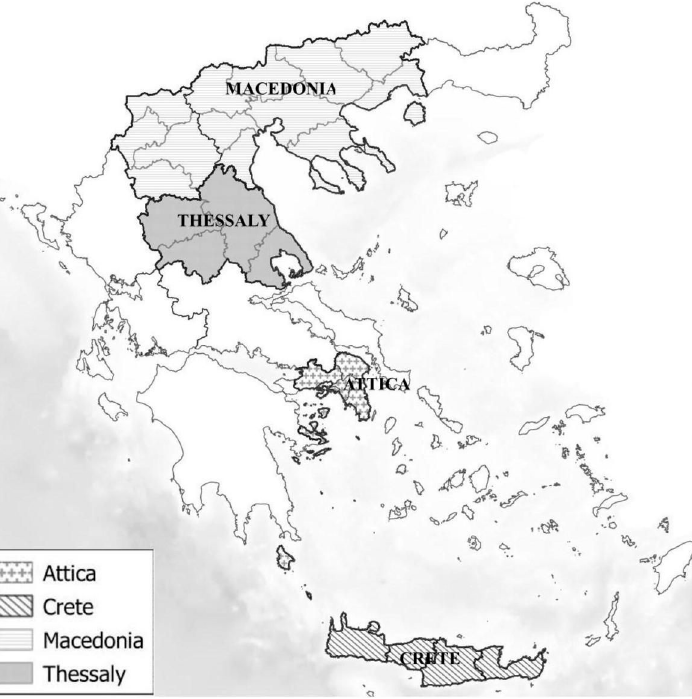
Figure 1. Map of the study area. Cats from the region of Attica, Crete, Macedonia and Thessaly were prospectively